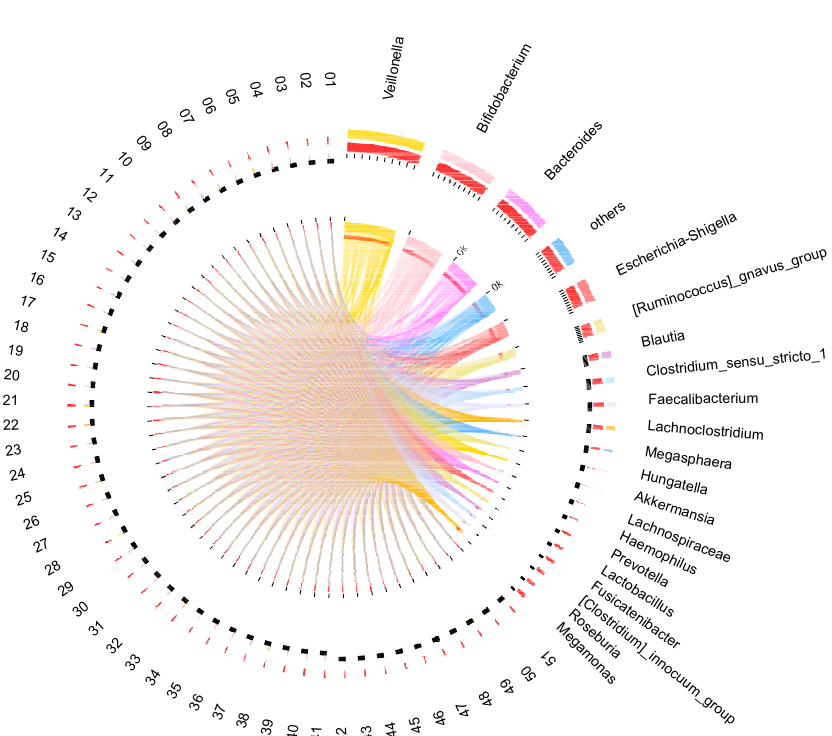
Figure 1. Distribution of microbial community for each sample at genus level. The data were visualized by Circos, and the width of the bars from each genus indicate the relative abundance of that genus in the sample.